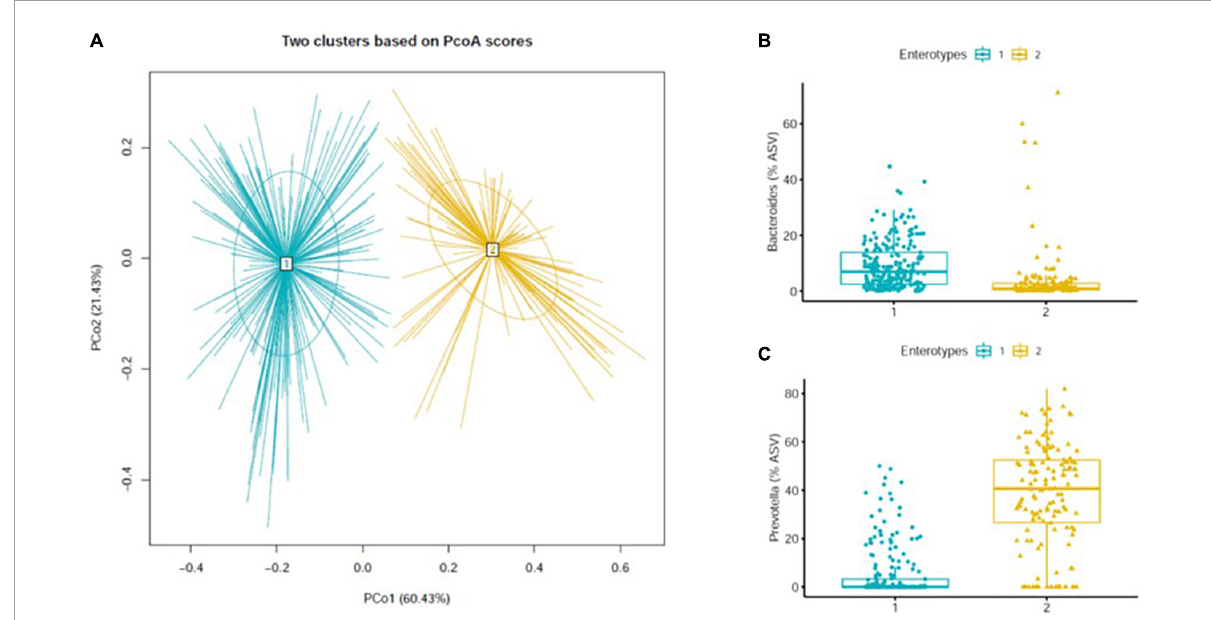
FIGURE1 Enterotypes of gut microbiota based on weighted UniFrac distance matrix (A) and the two different enterotypes identified by one of the following dominant genera; Bacteroides (B) , and Prevotella (C) . Dominant bacteria genus of each enterotype were presented as relative abundance [proportion of the amplicon sequence variant (%